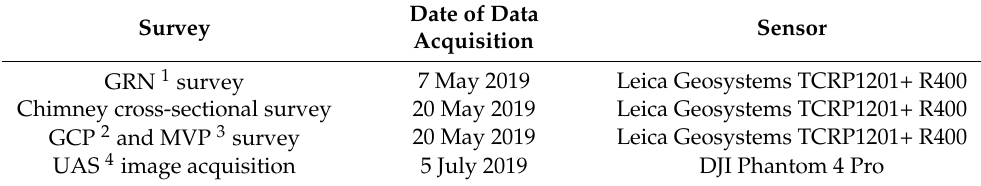
Figure 4. Geodetic sensors and accessories used in this research; ( a ) total station (TS) Leica Geosystems TCRP1201+ R400; ( b ) survey accessories: tripod (Leica Geosystems GST20); tribrach (Leica Geosystems GDF322); reflector carrier (Leica Geosystems GRT144); reflector (Leica Geosystems GPR121); ( c ) unmanned aerial vehicle (UAV) DJI Phantom 4 Pro. Table 1. Summary of field data